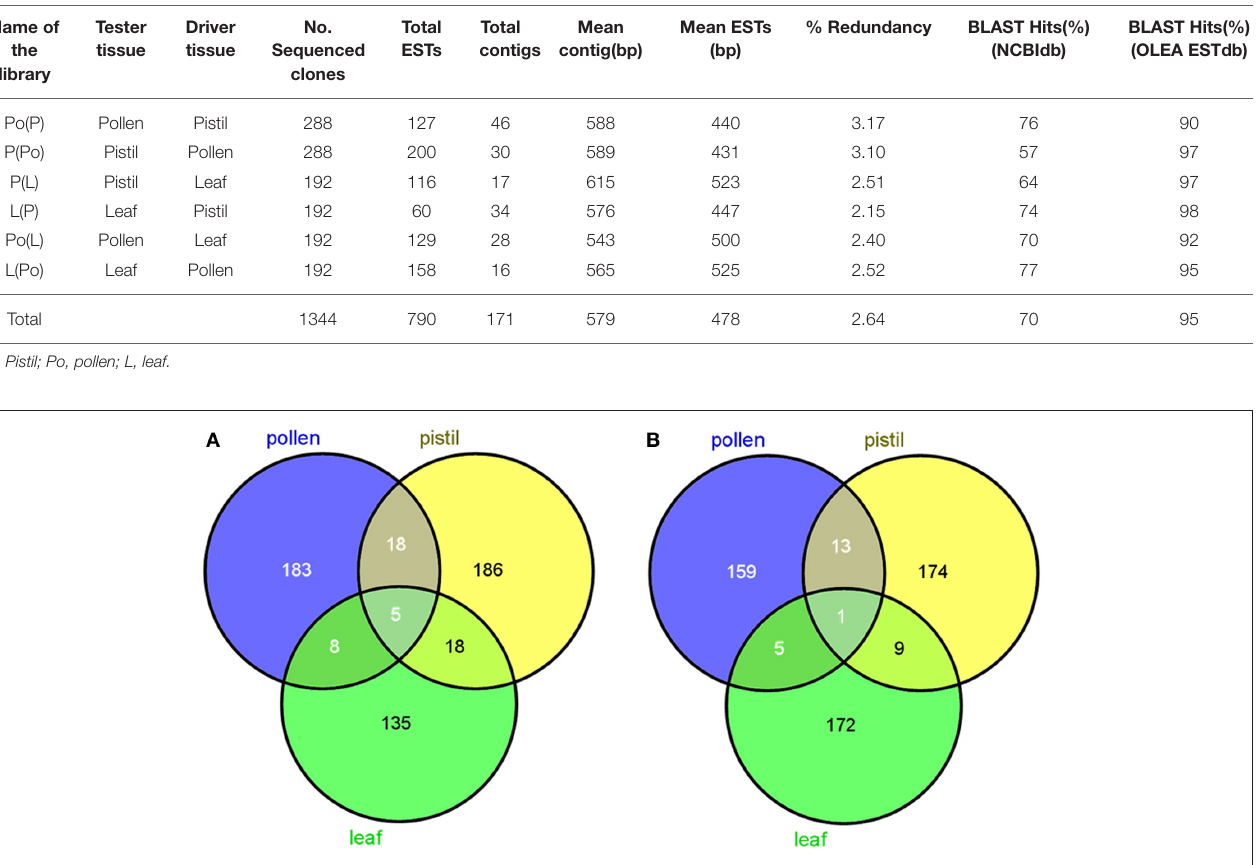
TABLE 1 | SSH libraries constructed and descriptive parameters about the clones sequenced.